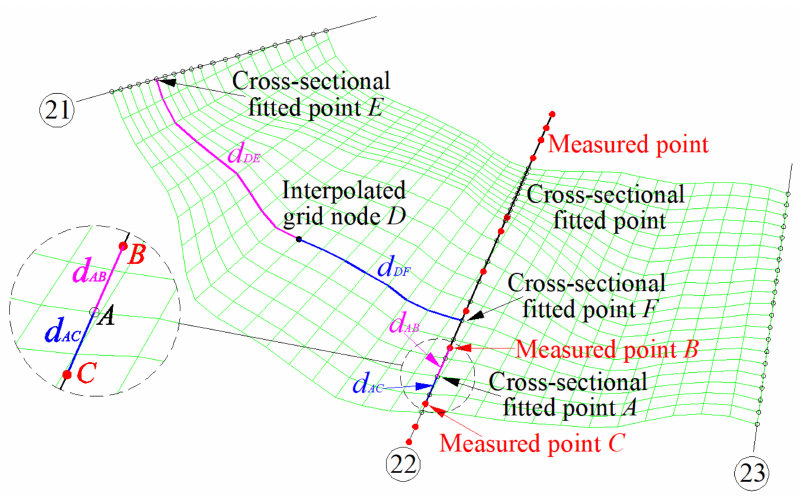
Figure 5. Transverse refinement effect of the preliminary grids and elevation interpolation schematic by the weighted distance method (In the process of the illustrative transverse refinement, the trans- verse segmentation numbers between the adjacent longitudinal control lines from the left side to right side are all